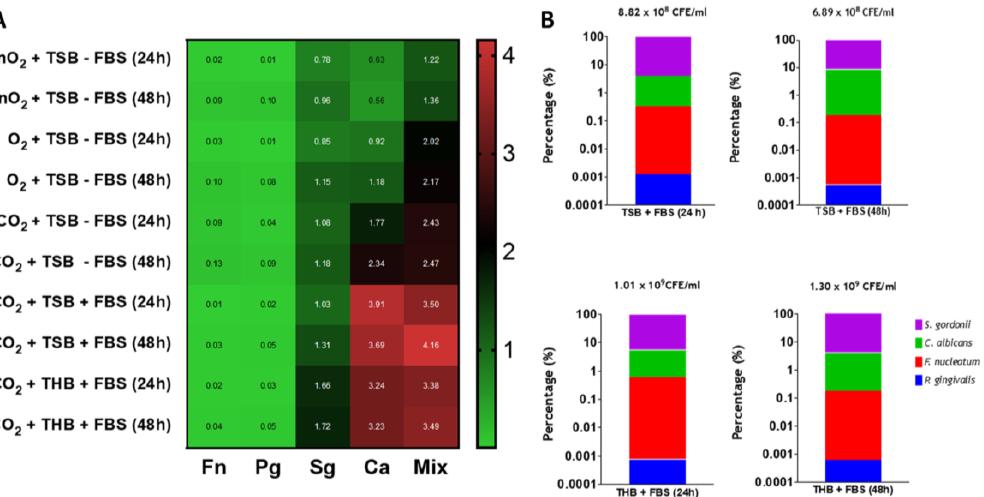
Figure 2. Biomass and compositional analysis of mono- and multi- species biofilms. ( A ) Heatmap analyses. Biomass quantification via crystal violet assessment of mono- and multi-species biofilms grown in three di ff erent incubation conditions (aerobically, 5% CO 2 and anaerobically) in a 1:1 mixture of either RPMI / TSB or RPMI / THB supplemented with 10% FBS for 24 h and 48 h in 24-well flat-bottom plates. Values in heatmap show the mean absorbance reading at 570 nm for all biofilms tested; ( B ) Compositional analysis of mixed biofilms. The graphs show percentage composition using colony forming equivalents (CFE) / mL of each microorganism in the multispecies biofilms grown in a 1:1 mixture of either RPMI / TSB or RPMI / THB supplemented with 10% FBS, for 24 h and 48 h in 6-well flat-bottom plates, in 5% CO 2 . Total CFE / mL for all four microorganisms are shown above each bar graph. All experiment are representative of n = 3 from three independent repeats.